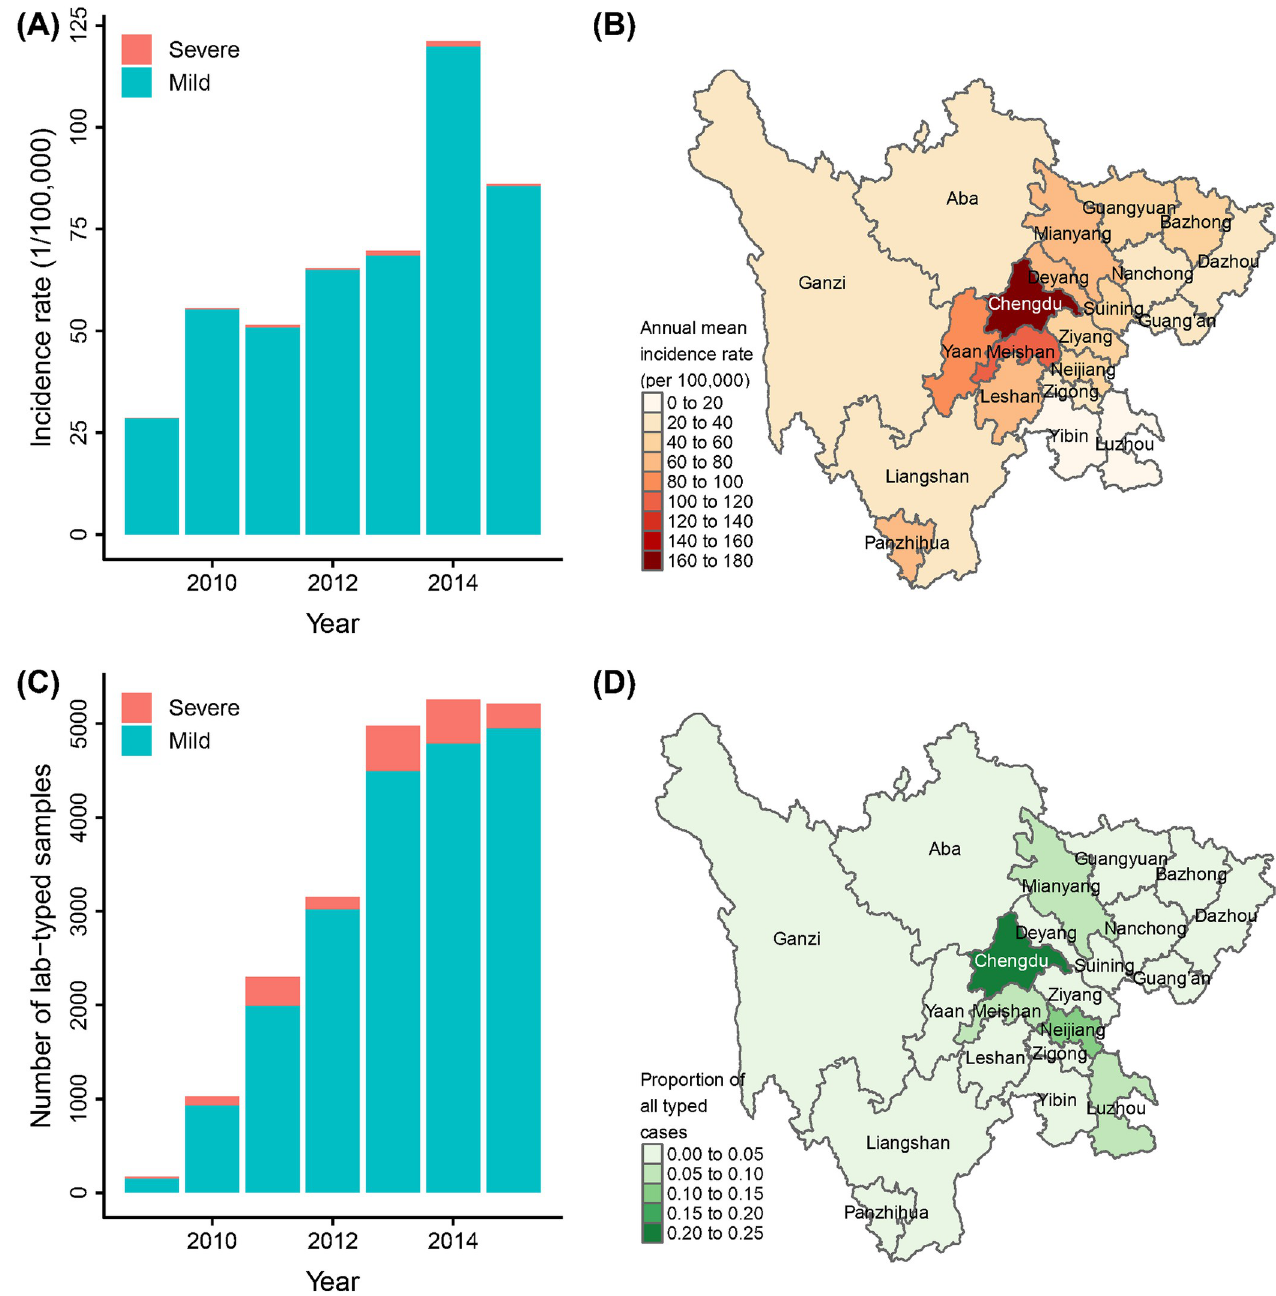
Fig 2. Temporal and spatial variations in HFMD incidence rate (A,B) and laboratory serotyping (C,D). (A) HFMD incidence rate for Sichuan 2009–2015; (B) annual mean HFMD incidence rate for each prefecture; (C) number of serotyped HFMD cases by year; (D) proportion of all serotyped cases drawn from each prefecture from 2009–2015. The boundaries of the prefectures were obtained from